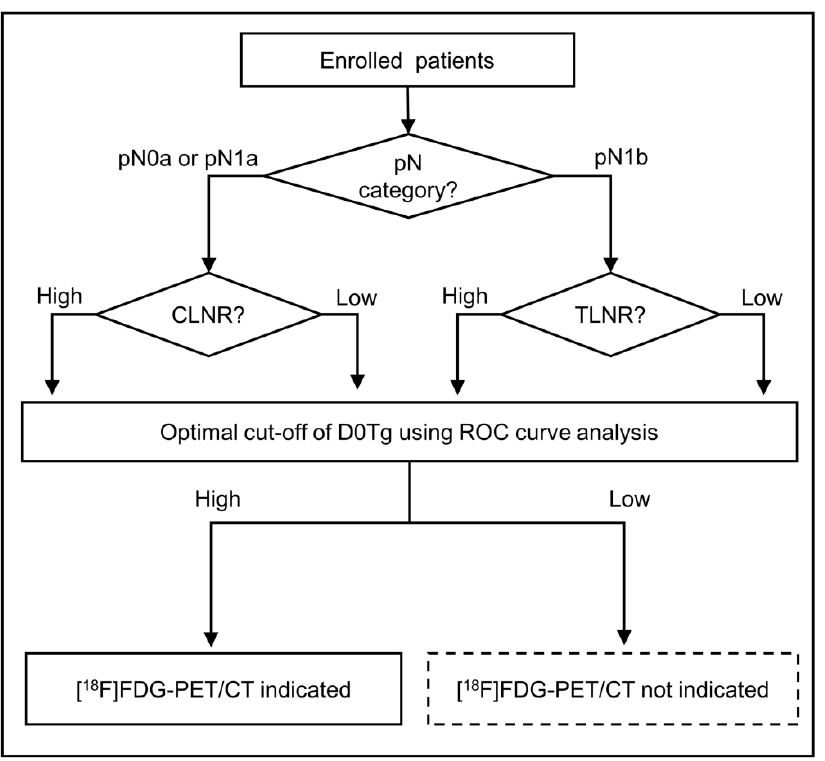
Figure 1. Diagnostic flow-chart for the identification of [ 18 F]FDG-PET/CT indication to detect FDG- avid persistent disease using metastatic lymph nodes ratio (LNR) and serum thyroglobulin (D0Tg). LNR was defined as the number of metastatic lymph nodes (MLNs) divided by the number of removed LNs. The optimal cut-off values of LNR and serum Tg were determined using the receiver operating characteristic curve analysis in each steps. (CLNR, central metastatic lymph nodes ratio; D0Tg, serum level of thyroglobulin (ng/mL) checked immediately before radioactive iodine therapy; TLNR, total metastatic lymph nodes ratio).